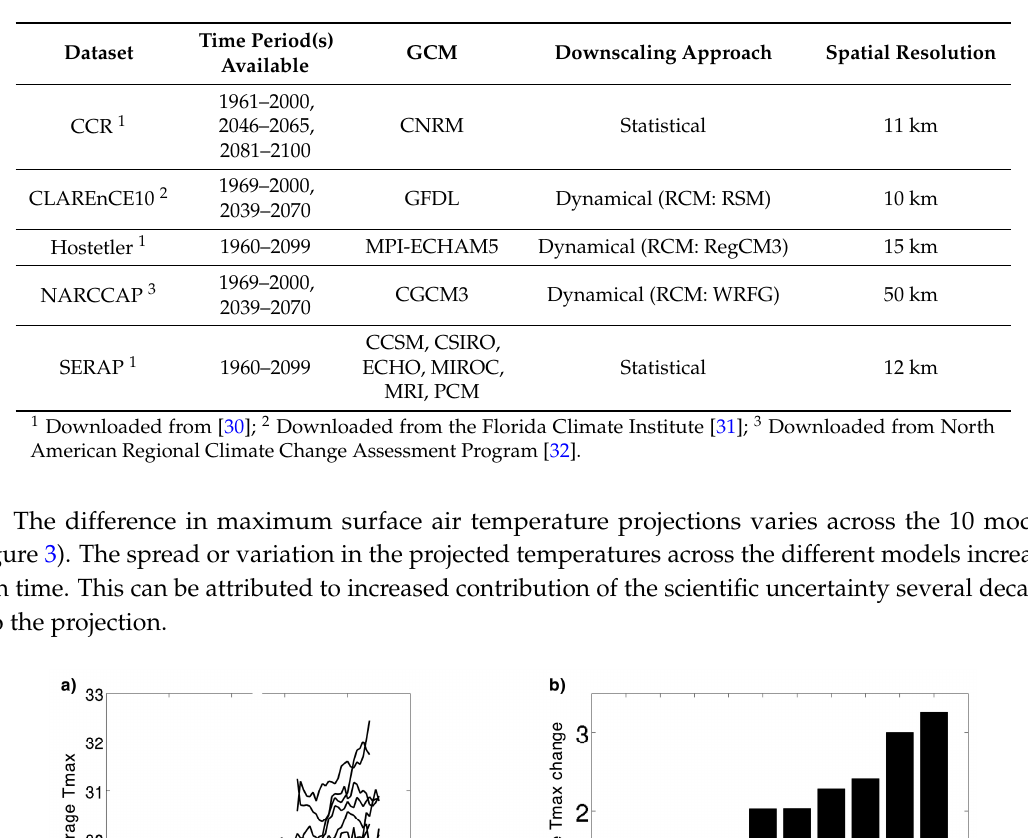
Table 1. Downscaled Coupled Model Intercomparison Project (CMIP)3-A2 scenario datasets used by Florida Building Resilience Against Climate Effects (BRACE).